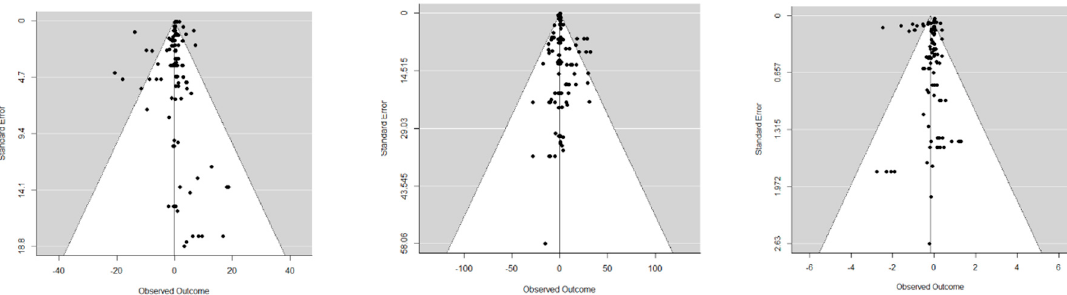
Figure 4. Funnel plots of the di ff erences in means of the average daily gain (left panel), feed intake (middle panel), and feed conversion ratio (right panel) between poultry fed a diet with and without